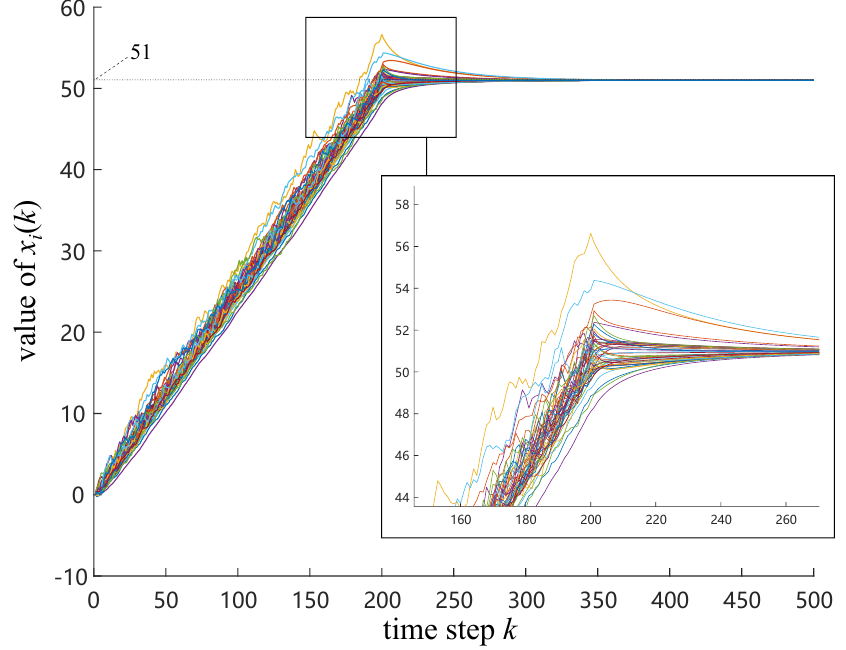
Figure 17. States evolution under uniform distribution of r i ( k )